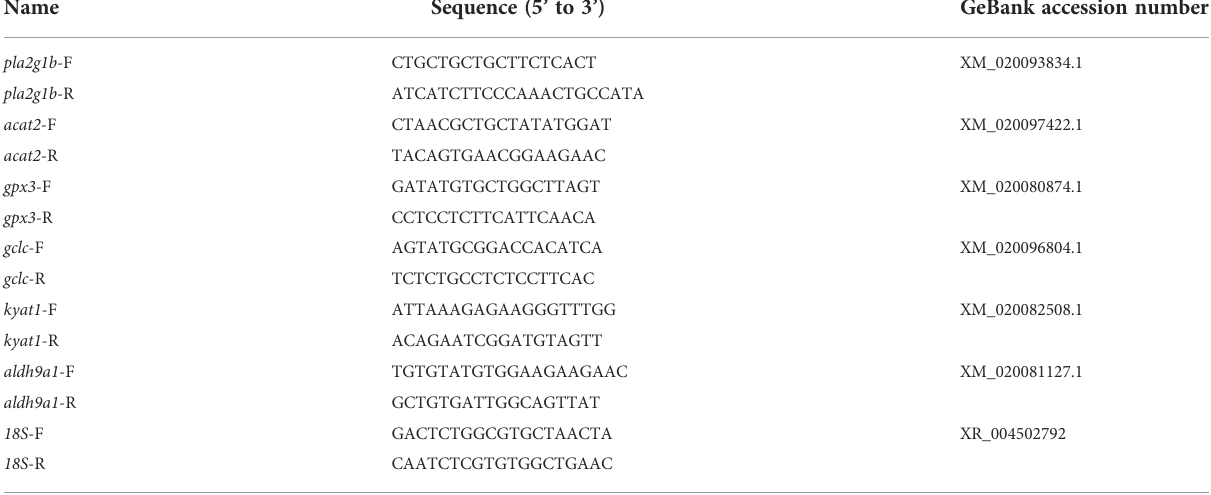
TABLE 1 The information of forward (F) and reverse (R) primers for target genes used in the qRT-PCR